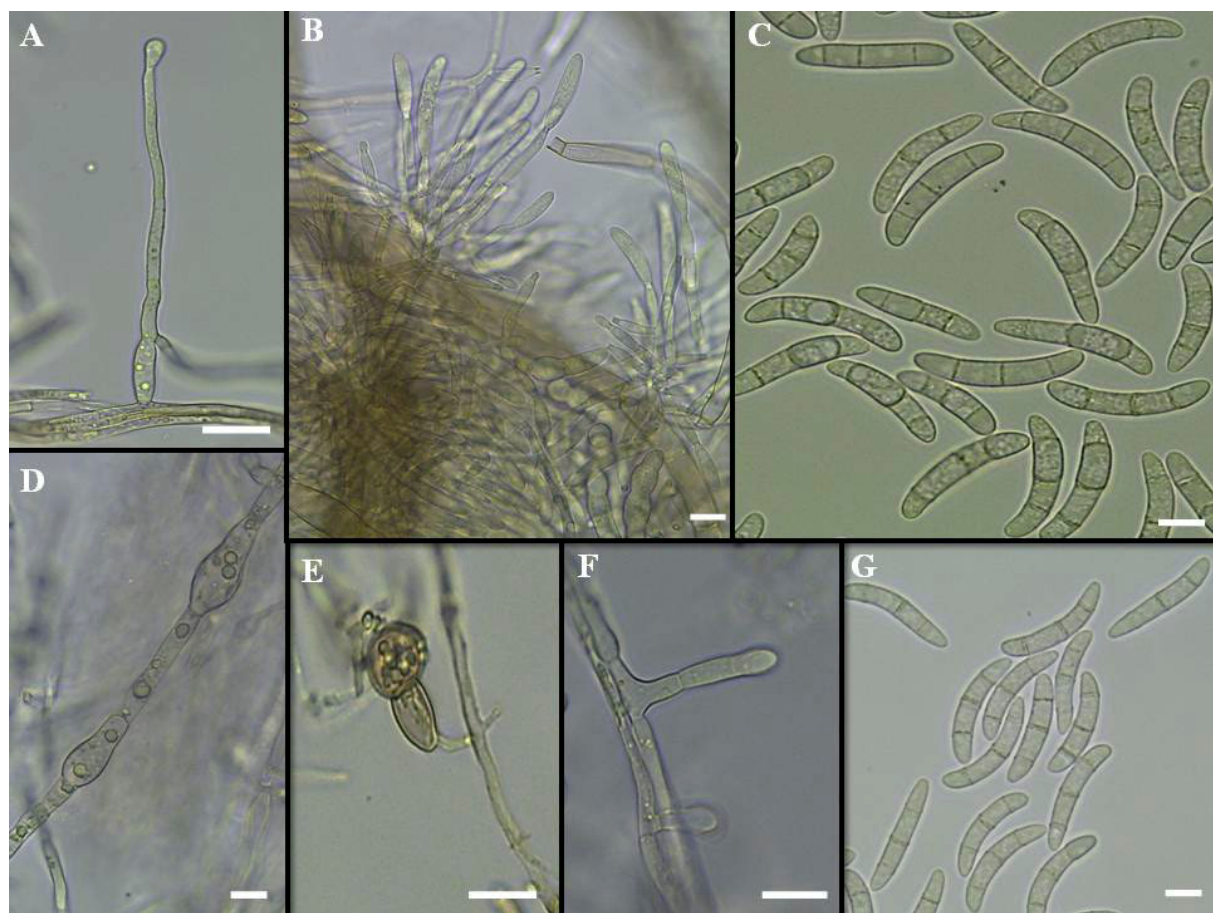
Figure 2. Campylocarpon pseudofasciculare (isolate Cy6UFSM): (A, F) simple conidiophores in aerial mycelium; (B) fascicles of branched conidiophores; (C, G) macroconidia; (D, E) chlamydospores in mycelium. Bars = 10